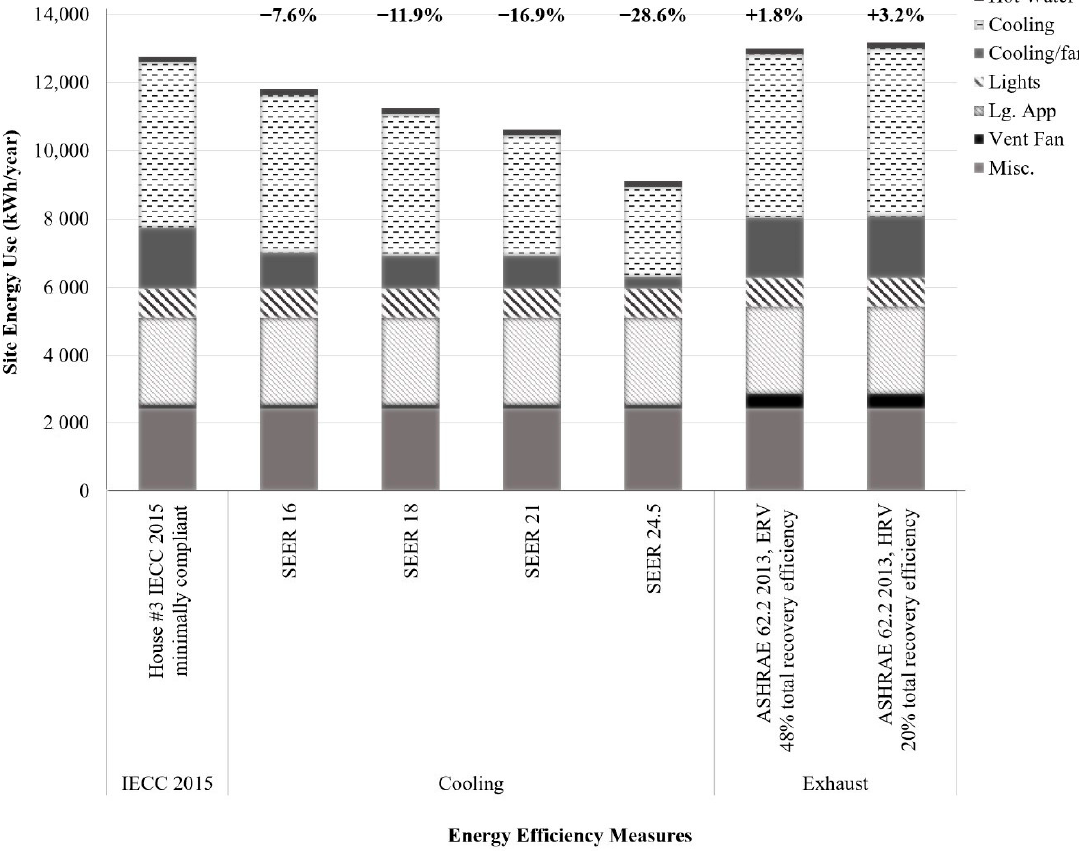
Figure 4. Simulated annual site energy (kWh / year) consumption for parametric cooling and mechanical Figure4 ventilation energy e ffi ciency measures vs. the IECC 2015 baseline. Percent changes in annual energy use are